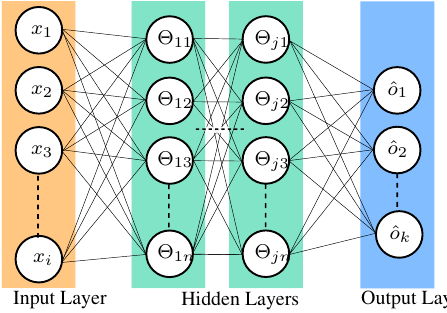
Figure 1. Base concept of a fully connected artificial neural network. The orange layer contains the input information, the green layers are j hidden layers and the blue output layer consists of k output classes.